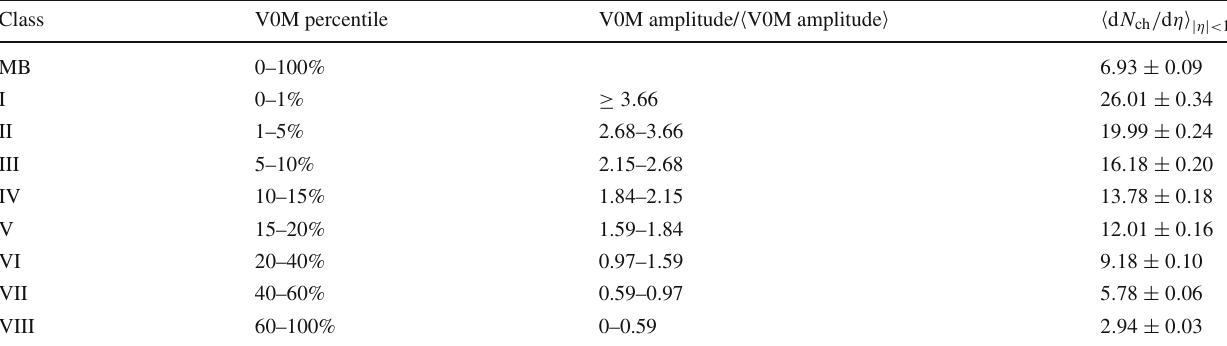
Fig. 1 Scaled V0M distribution which is used to determine the forward multiplicity classes in pp collisions at areas represent V0M multiplicity classes obtained from real data. The PYTHIA8 distribution is shown with the open black markers Table 1 Average charged-particle pseudorapidity densities at midrapidity (cid:5) d N ch / d η (cid:6) from data for inclusive events and different V0M